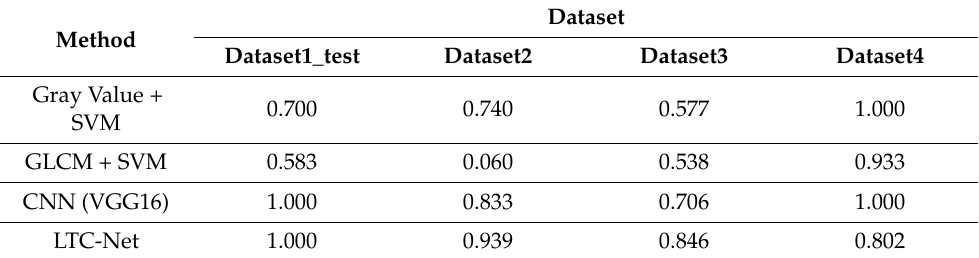
Table 6. Average accuracy of four